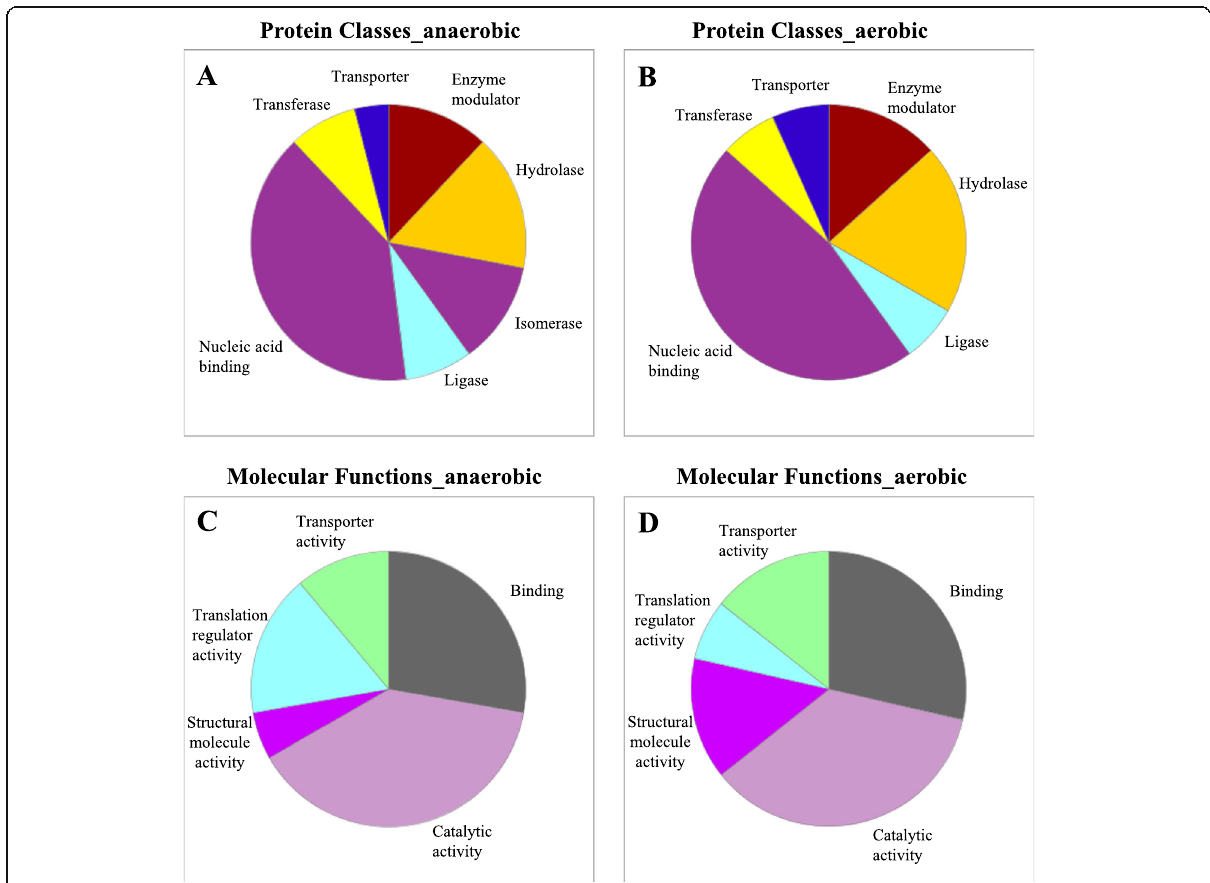
Fig. 4 The proteins identified in the fractions from Mycoplasma fermentans MFI cultured in aerobic and anaerobic conditions were analyzed using PANTHER software and classified according to protein class ( a : anaerobic, b : aerobic) and molecular functions ( c : anaerobic fraction, d : aerobic). Mycoplasma genitalium has been used as a reference genome for these classifications. In the analysis, PANTHER software did not include the following proteins: malL, asnA, xfp, argF, arcA, pmpr, hysA, abca, licA (anaerobic) and had, kduI, ndt, abca, licA, pcrA, rlmb. hysA